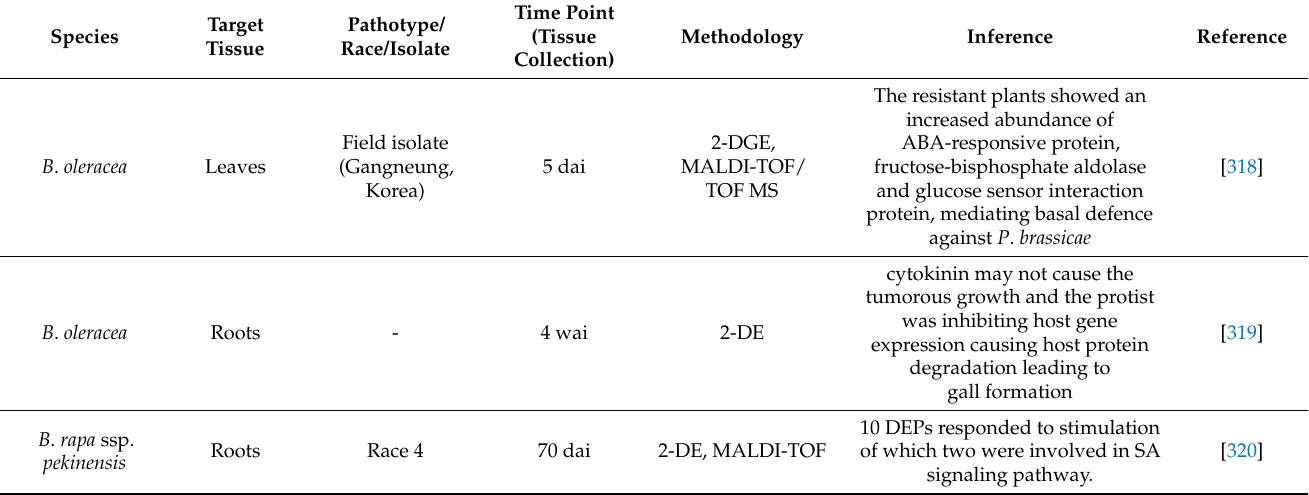
Table 5. Published proteomic analyses in Brassica spp. during interaction with